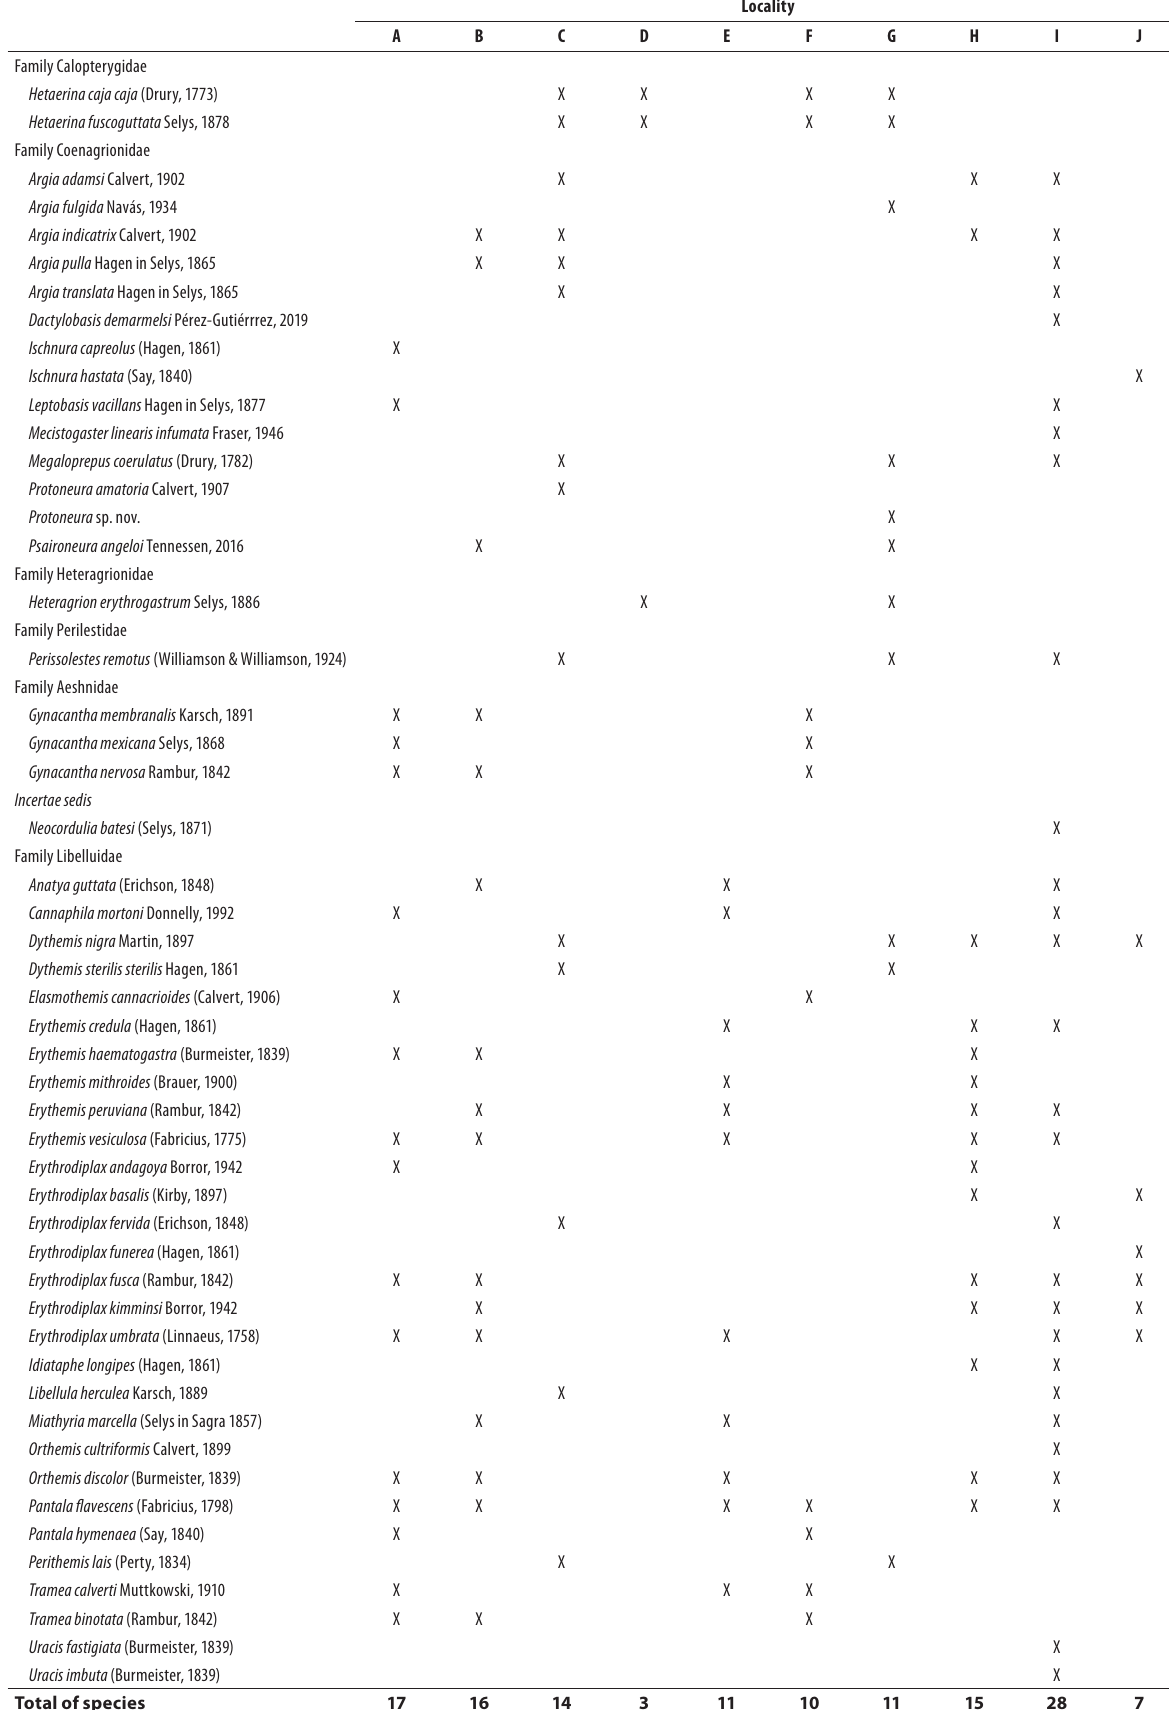
Table 2. Odonata species by site. A = puddles near Principal Park, B = Mecana Beach, C = Toledo Reserve, D = Coca-Cola Beach, E = Huina Beach, F = Quebrada Seca stream, G = Chocolatal stream, H = Babillal near the airport, I = El Valle, and J = Babillal between El Valle and Bahia Solano